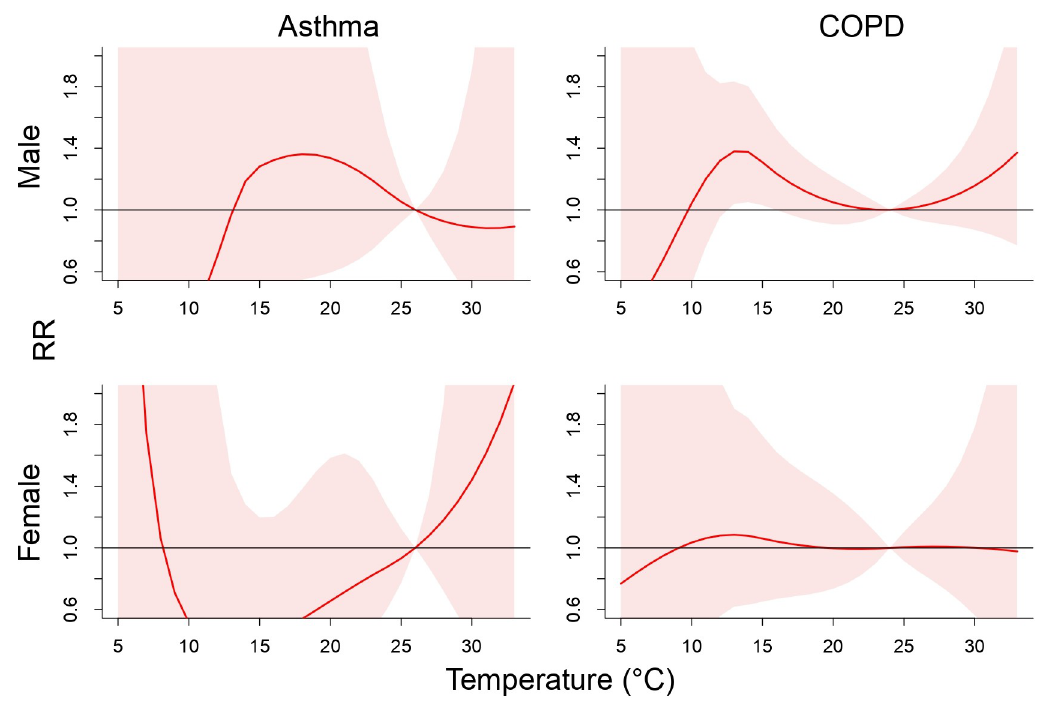
Fig 2. Cumulative 26-day (lag 0–25) relative risk (95% confidence interval) of sex-specific deaths for asthma and COPD in the elderly associated with daily average temperature.